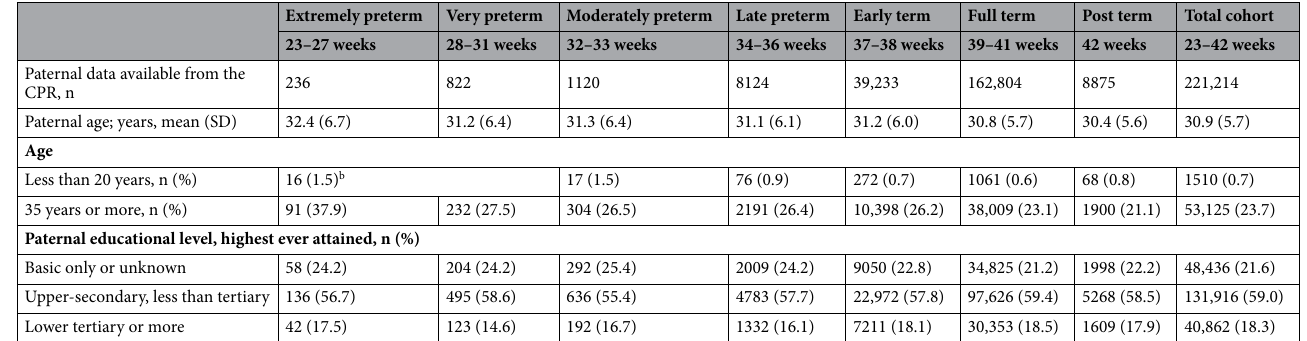
plementary Table S3, Fig. 2). Severe medical condition of the individual, maternal smoking, and low parental ages and education were risk factors for discontinued compulsory education (see Supplementary analyses), but GA was not. In models adjusted for all the covariates those born late preterm had slightly lower risk for discontinued compulsory education (Supplementary Table S4, Supplementary Figure S1). A total of 3.5% of those born at 23–33 weeks’ gestation had unknown type of education (i.e., other than special or mainstream education or discontinuing school attendance) as compared to 1.5% of their full-term born peers. The corresponding percentages for those born late preterm or early term were 2.2% and 1.6% respectively.